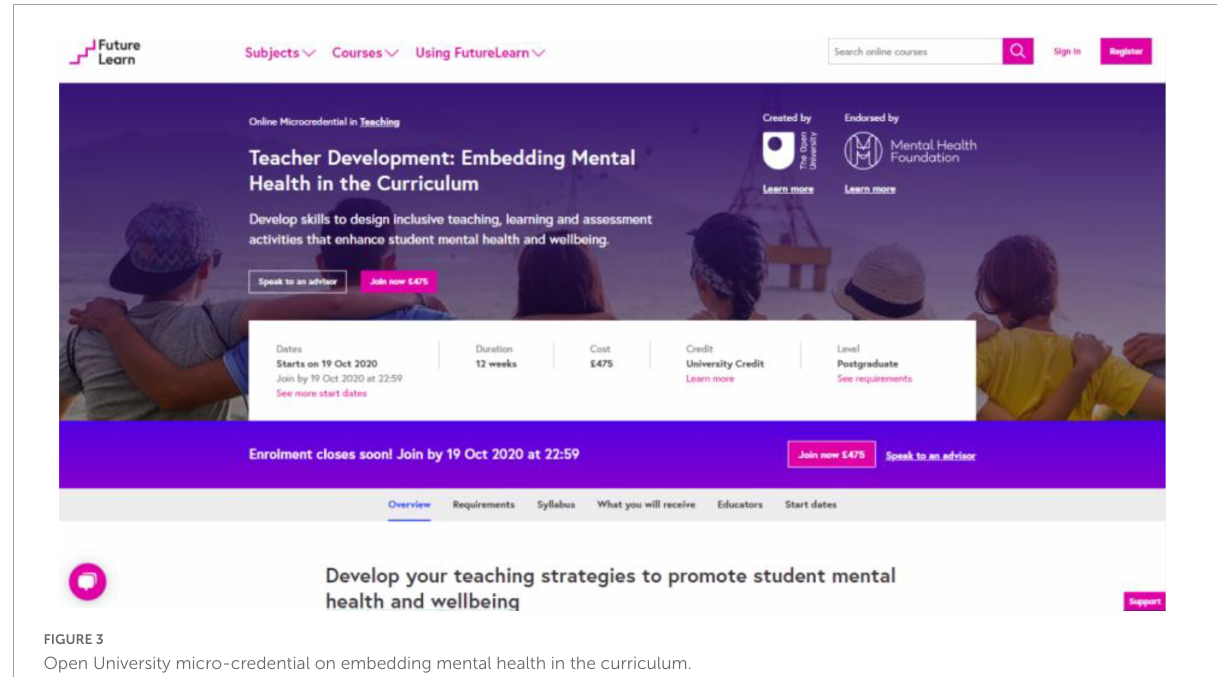
FIGURE3 Open University micro-credential on embedding mental health in the